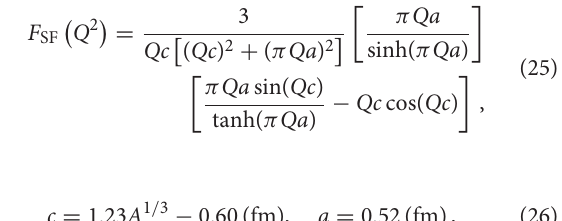
FIGURE 4 | Integrated CE ν NS cross sections σ ν targets ranging from light to heavy isotopes. Figure adapted from